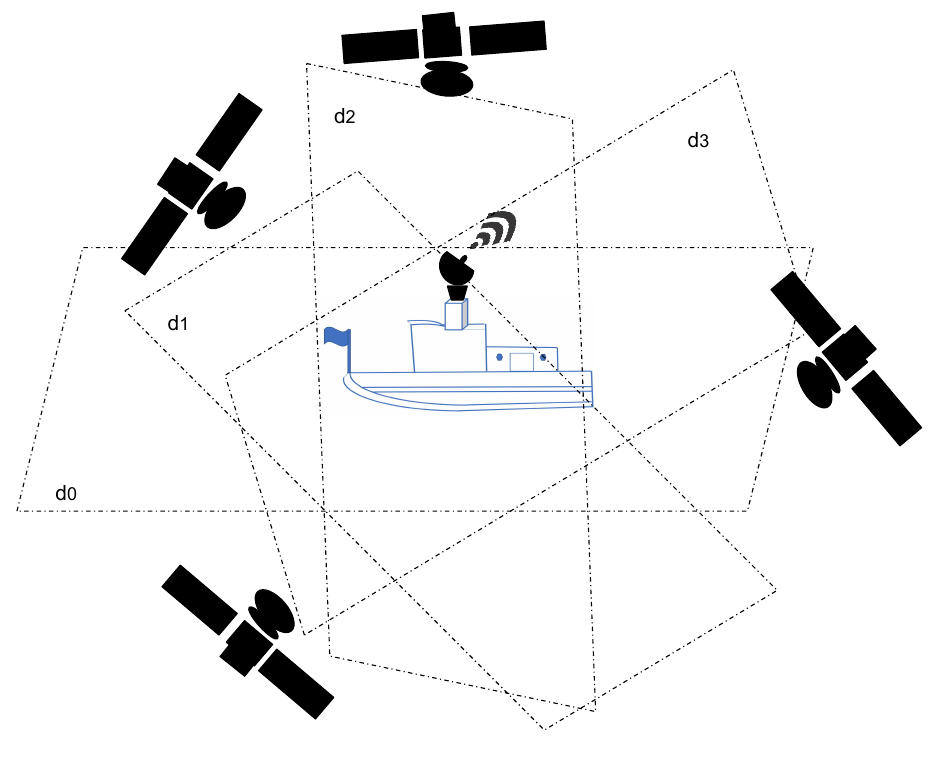
Figure 10. GPS receiver